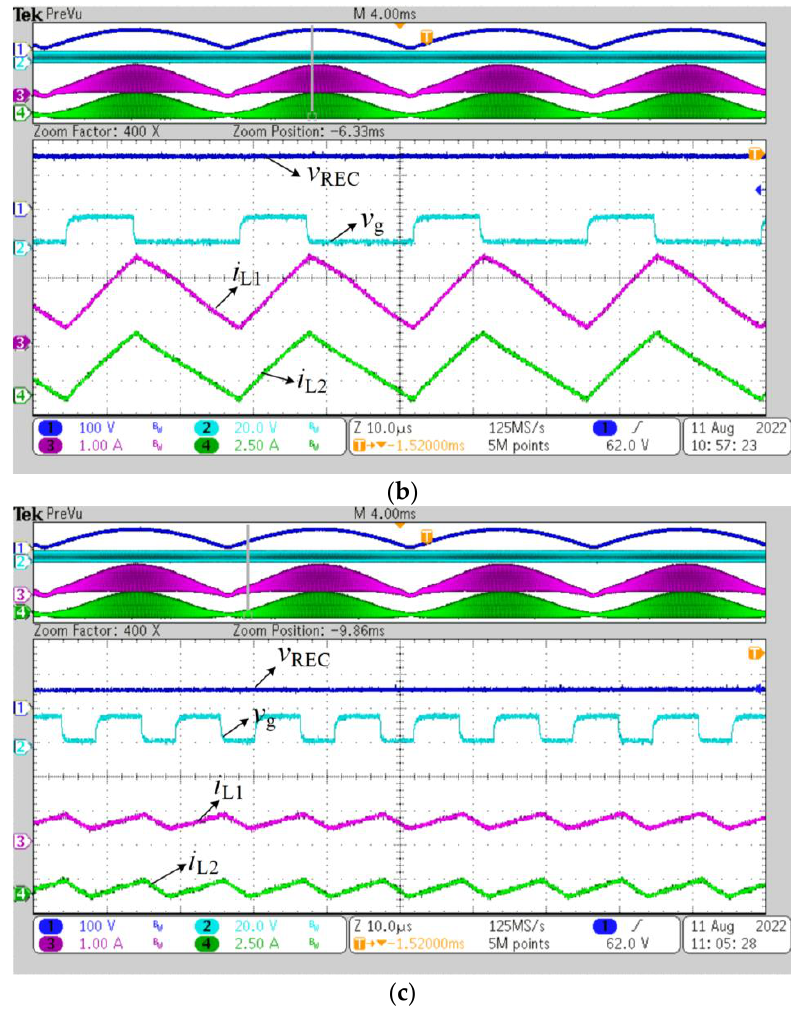
Figure 22. Experimental waveforms of v REC , v g , i L 1 , and i L 2 of VOT control with 110 Vac input voltage and rated current load. ( a ) overall waveform; ( b ) zoomed-in waveform at ωt = π/2, i.e., v Rec is 155 V; ( c ) zoomed-in waveform around zero-cross point of input voltage, v Rec is 50 V.